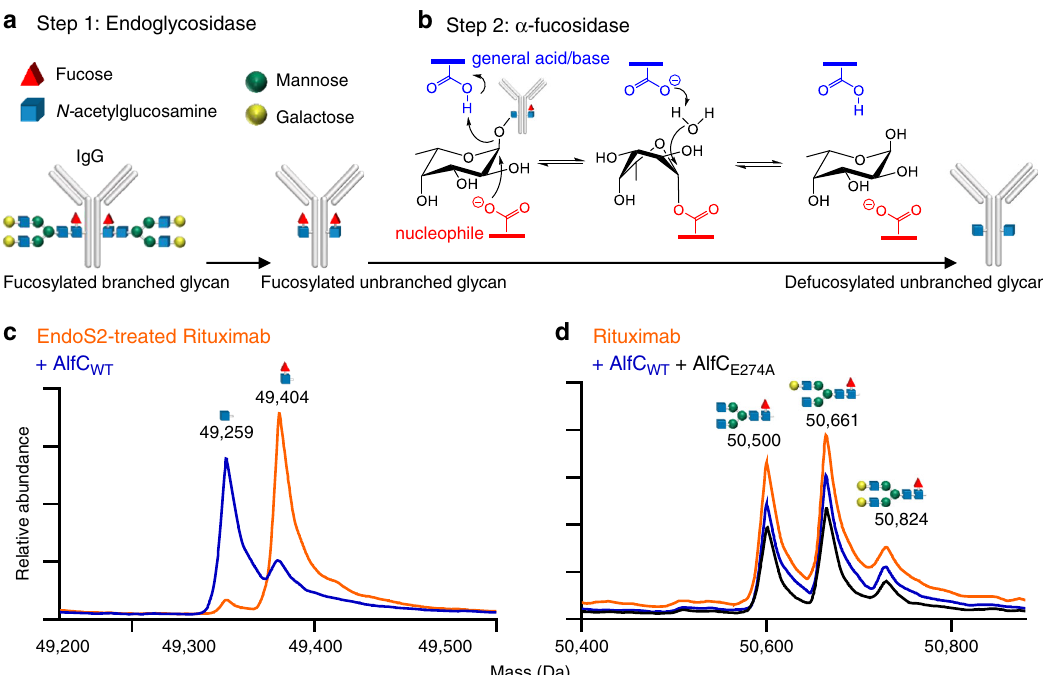
Fig. 1 Defucosylation of IgG. a Antibodies are treated with an endoglycosidase, leaving an N- linked disaccharide. b Alpha-fucosidase defucosylation proceeds through a Koshland double-displacement reaction with retaining stereochemistry. c Mass spectrometry of AlfC-treated Rituximab in the presence of EndoS2; d AlfC-treated Rituximab in the absence of EndoS2. Mass spectrometry plots have been re-traced and overlaid for clarity. Source data are provided as a Source Data fi